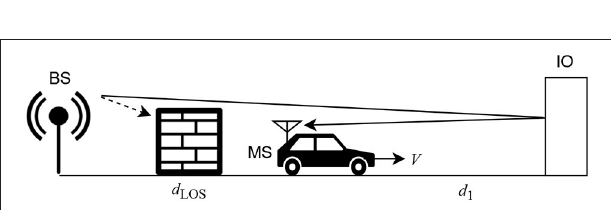
FIGURE 8 | Communications through an IO with a blocked LOS